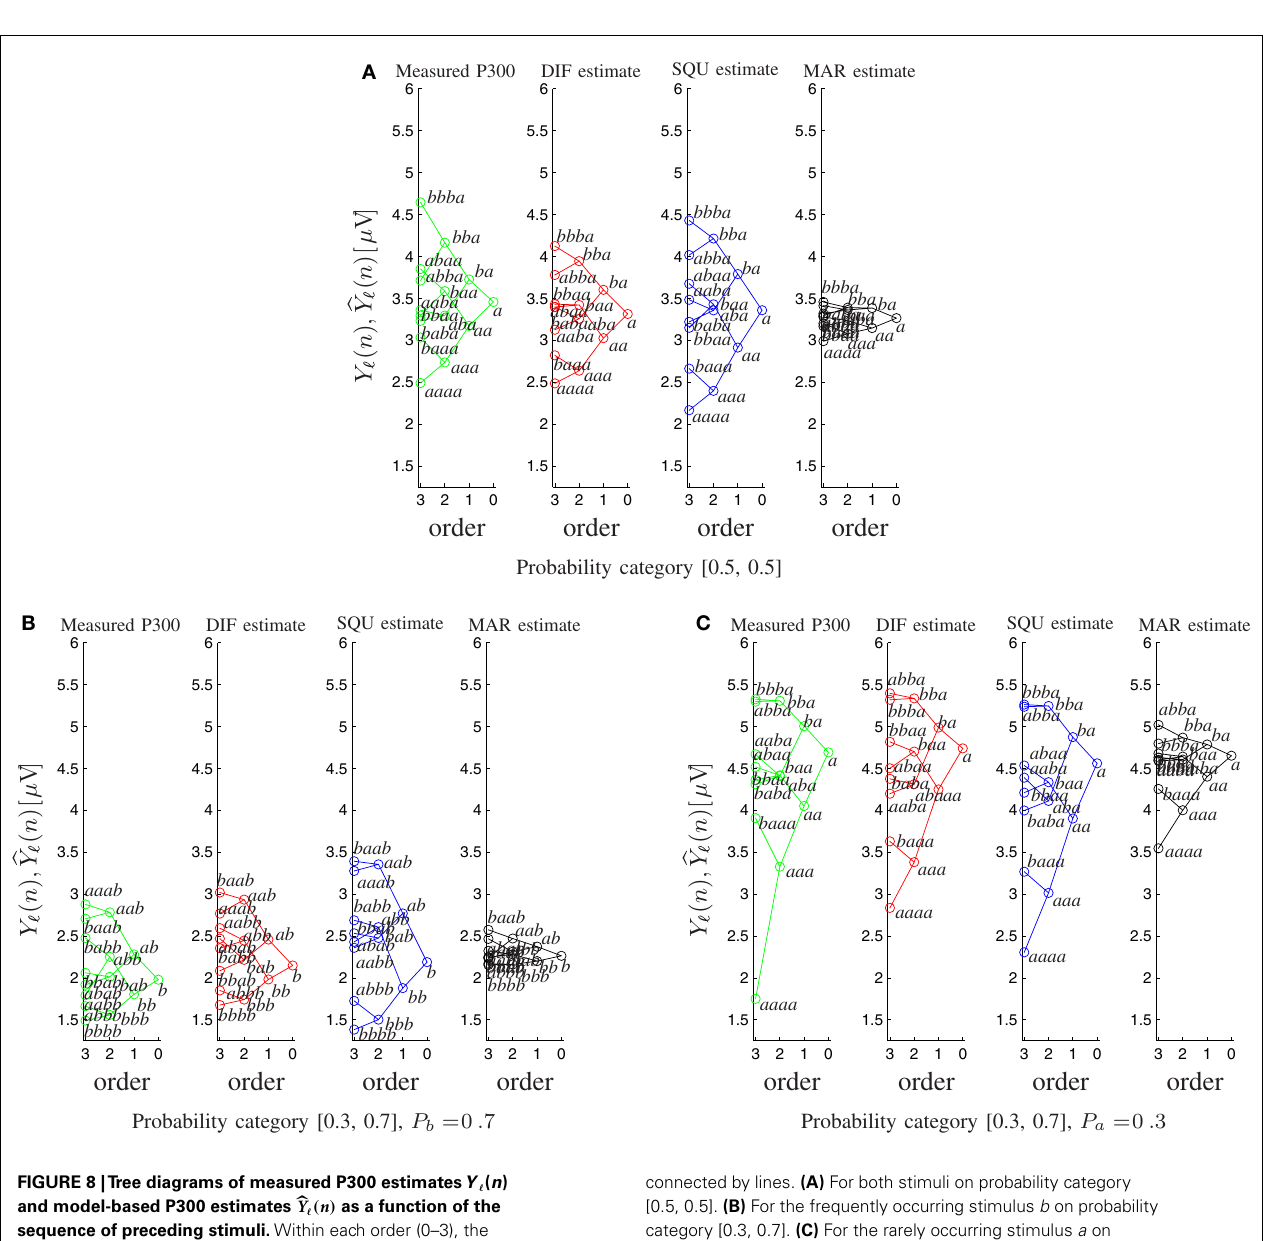
FIGURE 8 |Tree diagrams of measured P300 estimates Y (cid:96) ( n ) and model-based P300 estimates (cid:98) Y (cid:96) ( n ) as a function of the sequence of preceding stimuli. Within each order (0–3), the stimulus sequence is labeled, and related sequences are